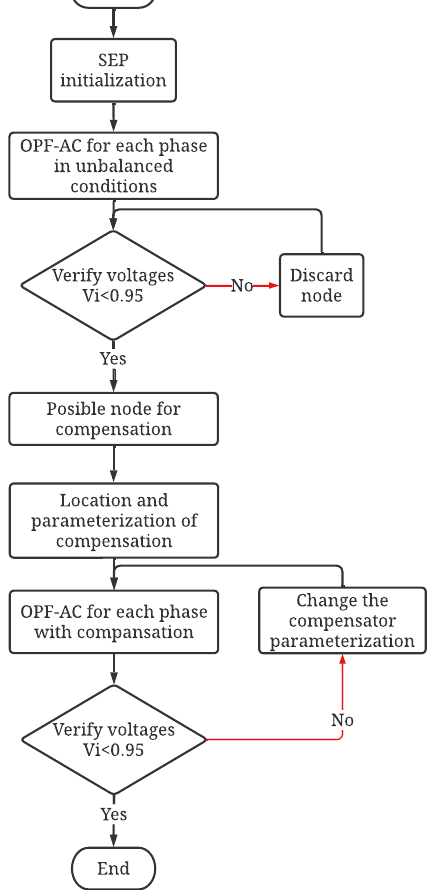
Figure 4. Flowchart of location of reactive compensation in unbalanced